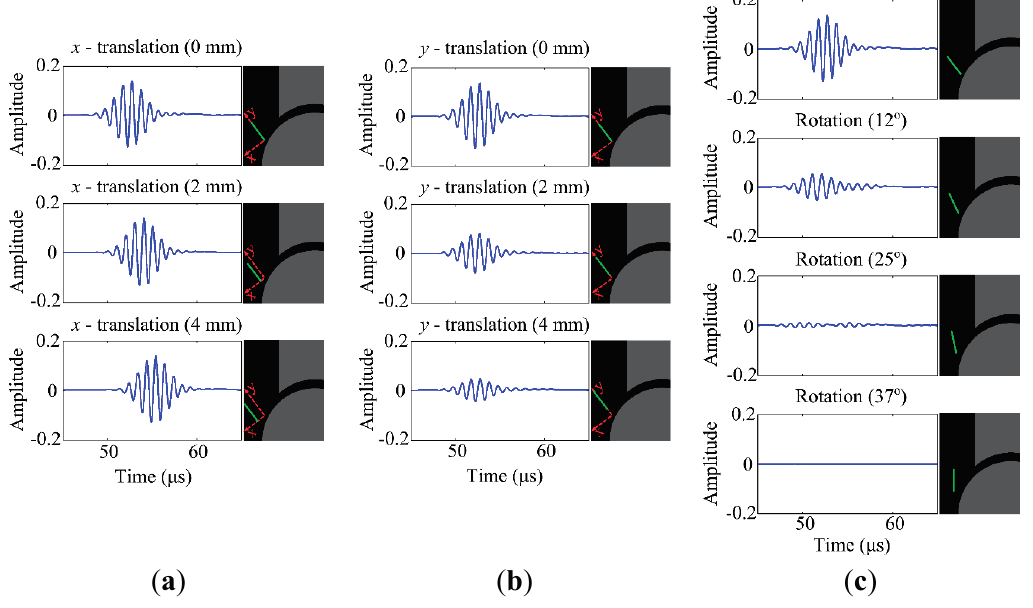
Figure 7. ( a ) Outputs of the parametric models simulating translation of US transducer ( i.e. transmitter) in x- direction. Orientations of the transmitter and the receiver were kept identical to those in the reference model ( i.e. , 37° from vertical); ( b ) Outputs of the parametric models simulating translation of US transducer ( i.e. , transmitter) in y- direction. Orientations of the transmitter and the receiver were kept identical to those in the reference model ( i.e. , 37° from vertical); ( c ) Outputs of the parametric models simulating rotation of US transducer ( i.e. , transmitter). Position and orientation of the receiver were not changed and kept identical to those in the reference